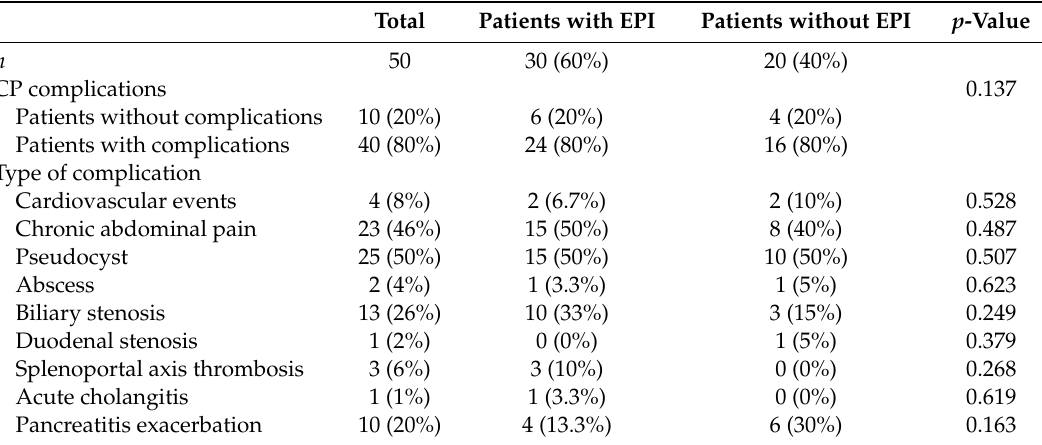
Table 3. Complications of chronic pancreatitis.